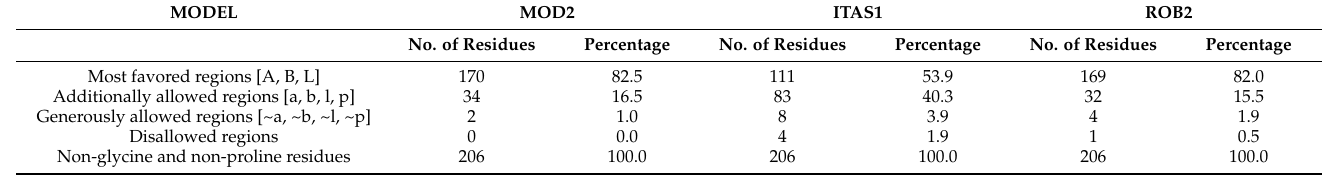
Figure 2. Ramachandran plot of the selected WSP model (ROB2) obtained via PROCHECK. The percentages of residues in the most favored regions, additionally allowed regions, generously allowed regions and disallowed regions are 82.0, 15.5, 1.9 and 0.5%, respectively. Table 1. Ramachandran plot statistics for the three best models from each modelling technique. For all the three models, the number of end residues (excluding Gly and Pro) = two, Glycine residues = 22, Proline residues = 11 and the total number of residues =